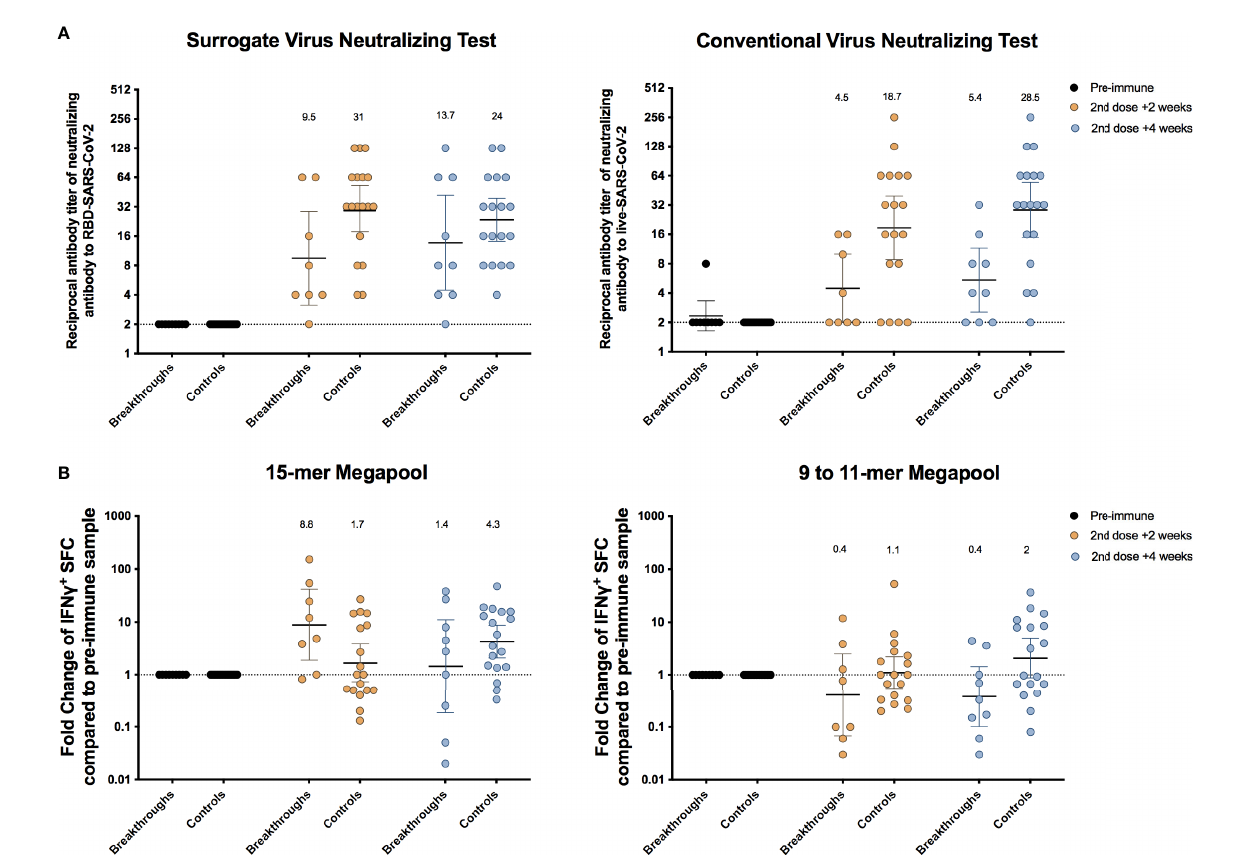
FIGURE 5 | Humoral and cellular immune responses of breakthrough cases as compared to a control cohort. A control cohort of 18 subjects who received two doses of the CoronaVac was selected by matching with breakthrough cases (2:1 ratio) according to the biological sex, range of age, and schedule of vaccination. (A) Titers of antibodies able to inhibit RBD-SARS-CoV-2 interaction with ACE2 receptor or surrogate virus neutralizing test (sVNT, left) and titers of neutralizing antibodies against infective SARS-CoV-2 or conventional virus neutralizing test (cVNT, right) detected in the breakthrough and control cohort. Serum samples were obtained before administration of the fi rst dose (preimmune), 2 and 4 weeks after the second dose. The numbers above the spots indicate GMT, and error bars show the 95% CI of the GMT. (B) Fold change of IFN- g + SFCs after stimulation of PBMCs with MPs containing 15-mer peptides (left) and 9- to 11-mer MPs (right) from SARS-CoV-2 proteome in the breakthrough and control cohort. PBMCs were obtained before administration of the fi rst dose (preimmune), 2 and 4 weeks after the second dose. The numbers above the spots indicate geometric mean of the fold increase regarding to the preimmune sample, and error bars show the 95% CI. GMT, geometric mean titer; PBMCs, peripheral blood mononuclear cells; MPs,